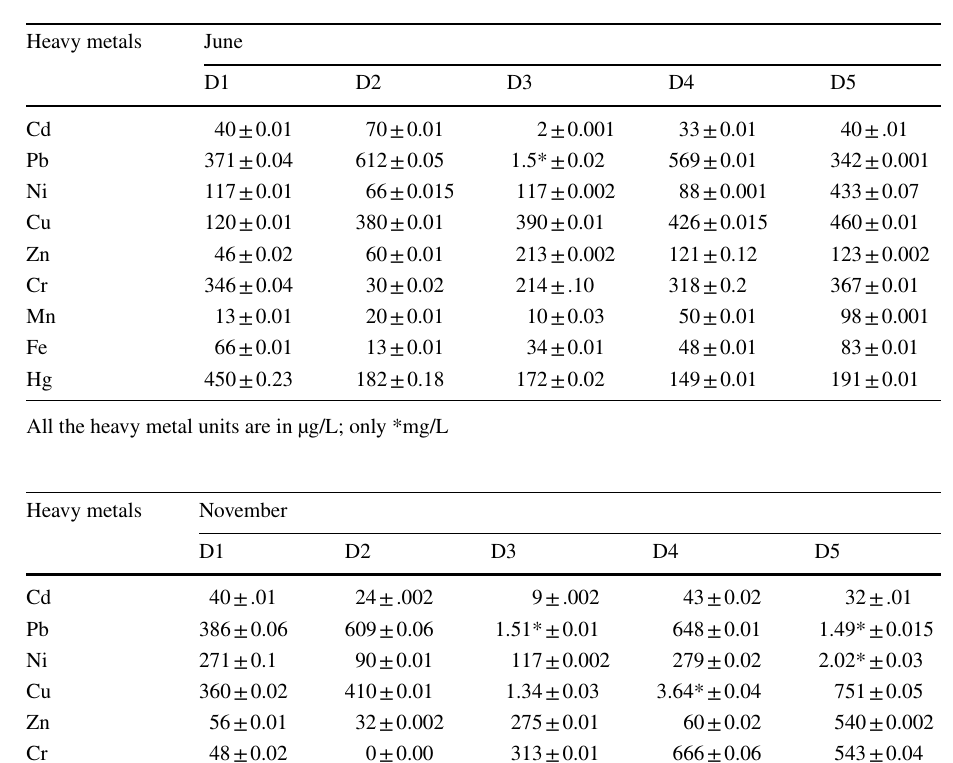
concentration in different drains of HIE during June-2012